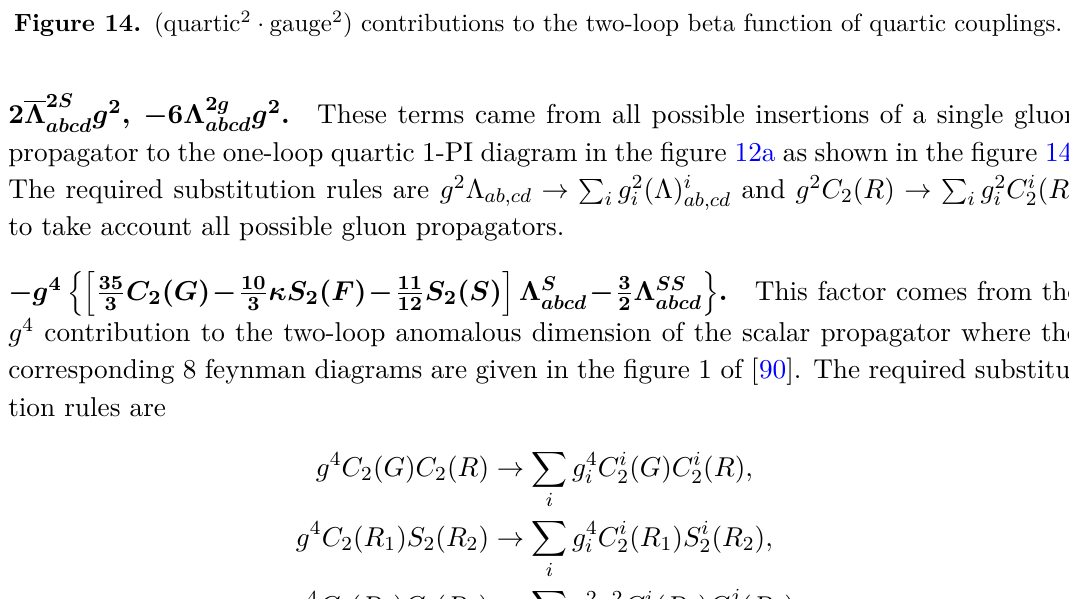
Figure 14. ( quartic 2 · gauge 2 ) contributions to the two-loop beta function of quartic couplings.